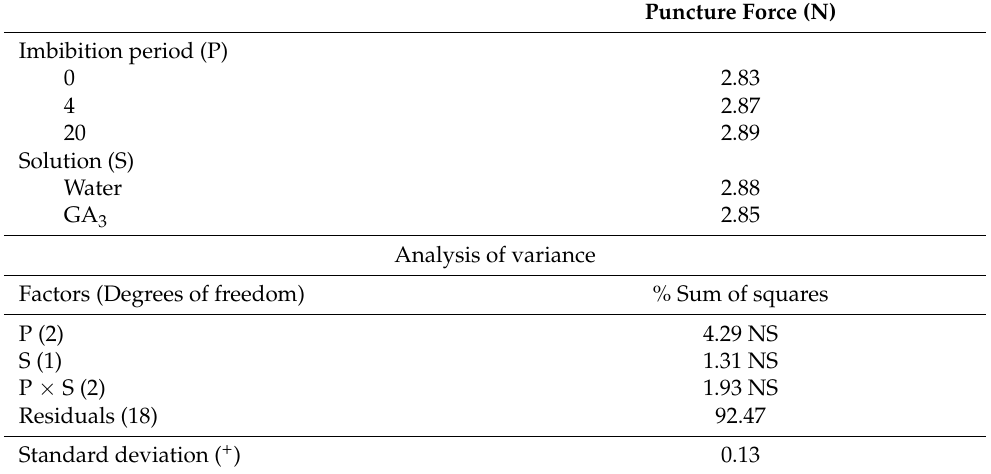
Table 3. Effect of the imbibition period (days from the beginning of the germination process) and the solution used to wet the germination substrate in the germination test on the puncture force necessary to pierce the testa at 0, 4 and 20 days after the start of the germination test. Average values of four replicates of 10 seeds